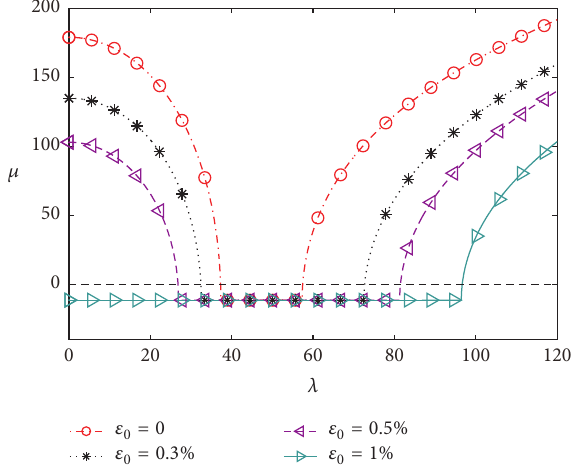
Figure 20: Influence of 𝜀 0 on stability boundary.